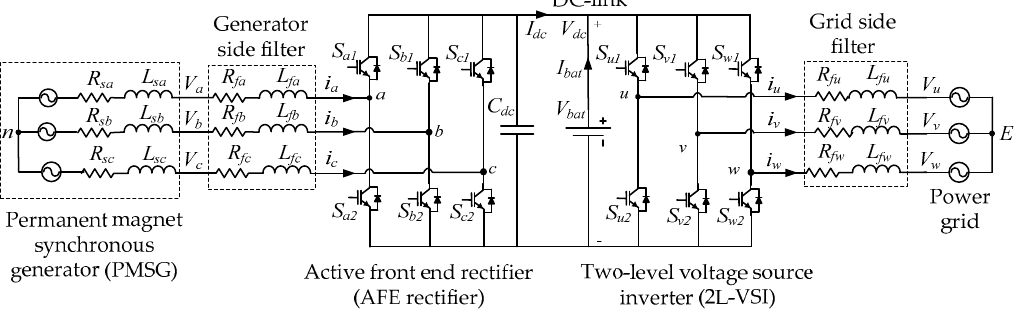
Figure 1. Schematic diagram of the proposed oscillating water column (OWC) air turbine generator—grid interface system.